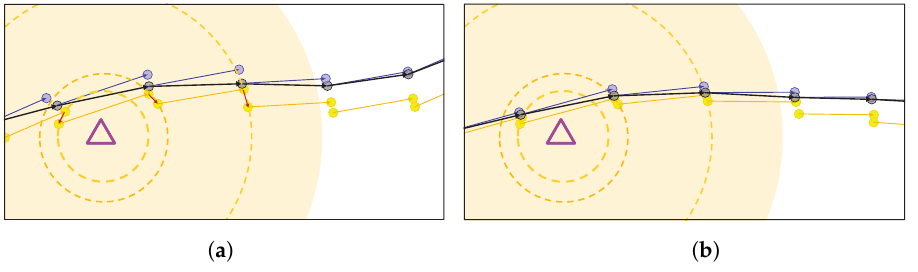
Figure 6. Example of algorithm operation according to INS error: ( a ) when INS accumulated error occurs and ( b ) when the accumulated INS error is